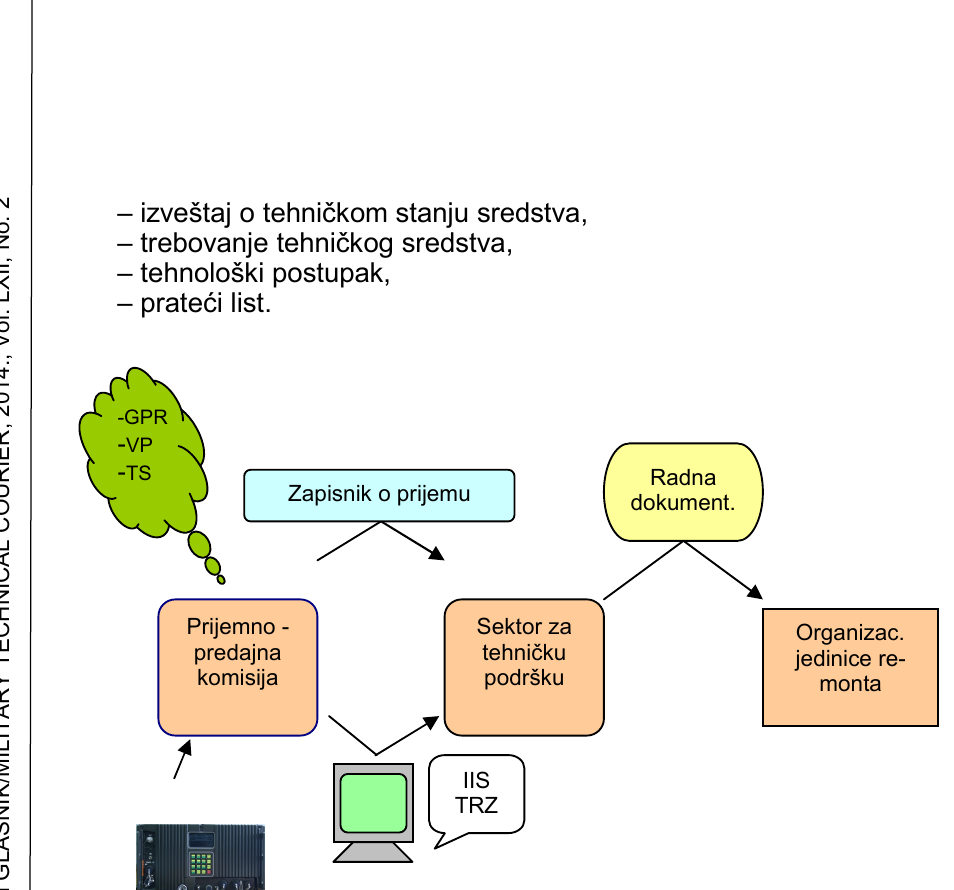
Figure 1 – Thef flow of acceptance of technical systems for overhauling and the formation of workingdocuments Zaduženje radne dokumentacije vrši lice iz organizacione jedinice koja je nosilac svih radova po radnom nalogu (nosilac RN – poslovo đ a odeljenja). Slede ć i korak je dostavljanje podnaloga ostalim u č esnicima u procesu remonta. Nakon završetka remonta STS, a posle potpisa nadle- žnih završnih kontrolora, vrši se razduženje radne dokumentacije, na istom mestu gde je i zadužena. Tok formiranja i postupak sa radnom do- kumentacijom prikazan je na slici